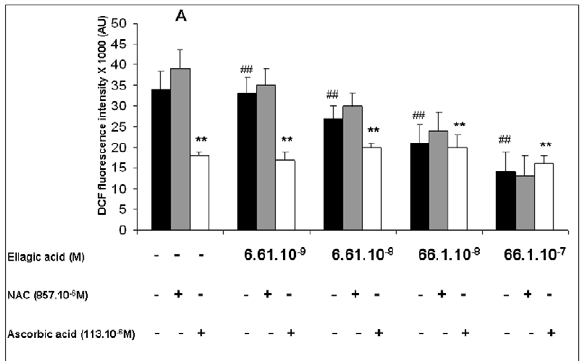
Table 1. Inhibition of ellagic acid antiplasmodial activity by antioxidants (ascorbic acid, N-acetyl-L- cysteine and glutathione ethyl-ester) on the FcM29 strain of Plasmodium falciparum . (p , 0.05) the ellagic acid antiplasmodial efficacy since the IC 50 obtained were increased 2.4 fold and 1.5 fold respectively. Data are expressed as mean 6 SEM for three independent experiments with triplicate sets in each assay. **p , 0.05 indicates a significant difference compared with ellagic acid mean IC 50.